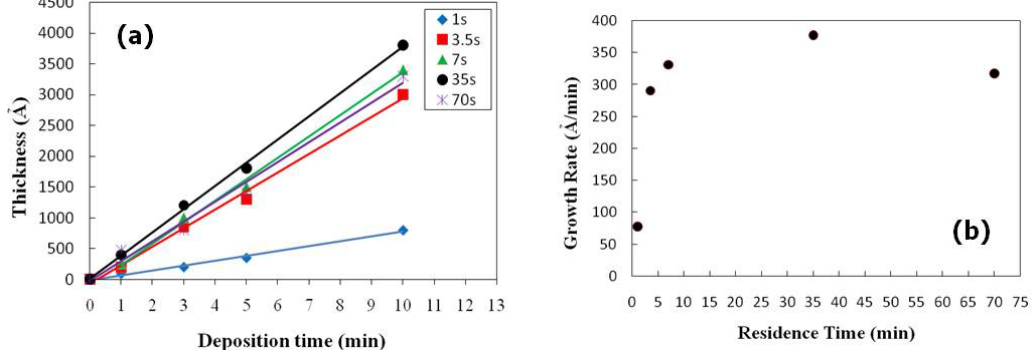
Figure 9. Fabrication of CdS thin film using MASD process: ( a ) CdS thin film thickness versus deposition time and ( b ) growth rate as a function of different residence times. Reproduced from [6].